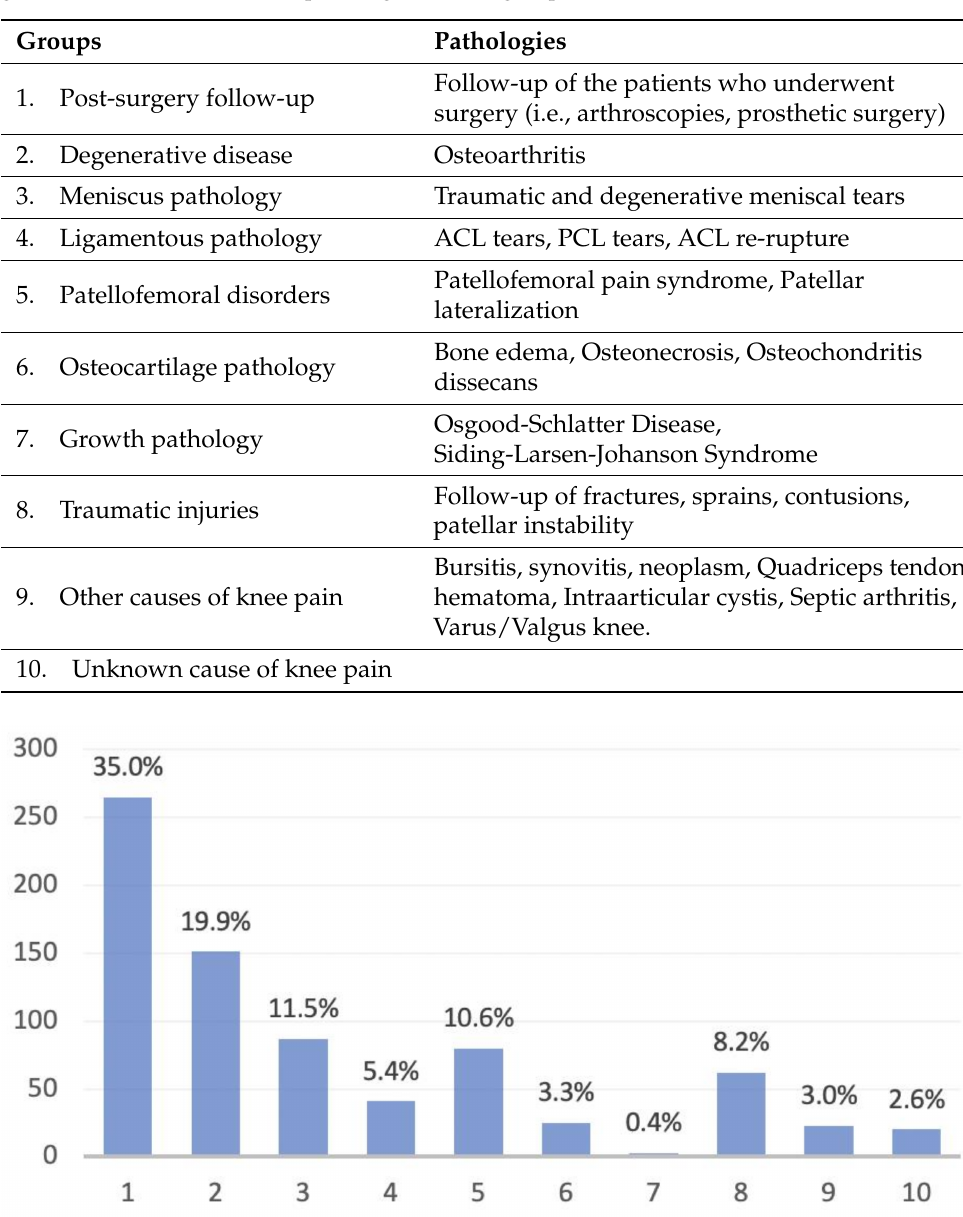
Table 1. Knee diagnoses groups. Groups of diagnosis related to the knee according to the etiopatho- genesis and the included knee pathologies of each group.